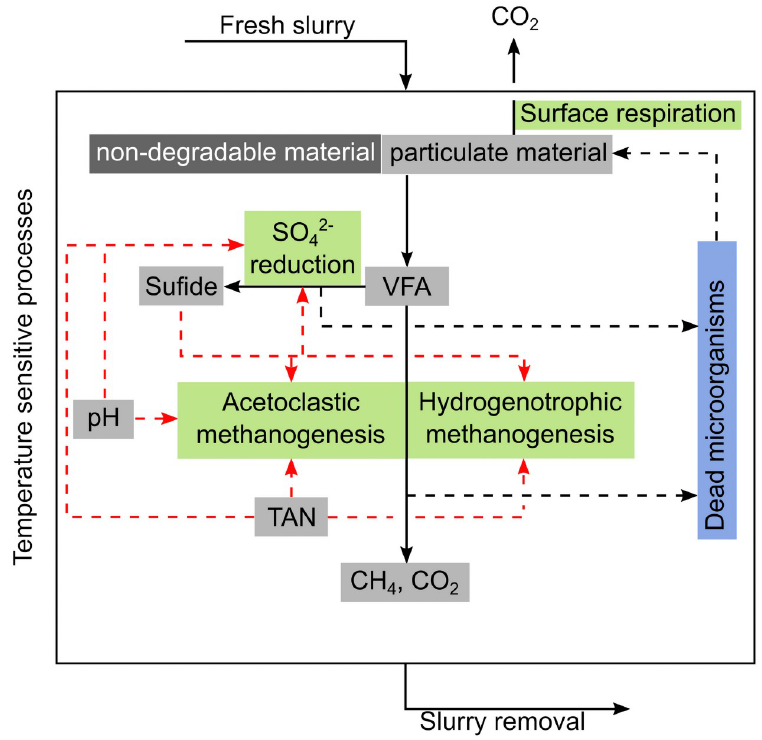
Fig 2. Flow diagram of model concept. Black lines indicate flows of organic matter, black dashed lines indicate flows of decayed microbial biomass. Red dashed lines indicate factors that inhibit microbial conversion processes (green boxes). Temperature affects all conversion processes, as well as chemical